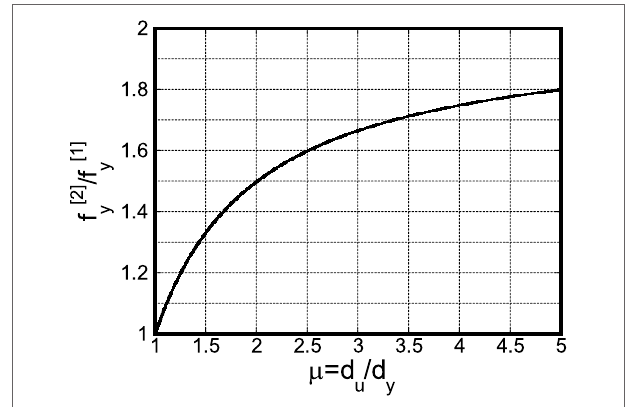
FIGURE 14 | f [2] y = f [1] y for μμμ = d u / d y